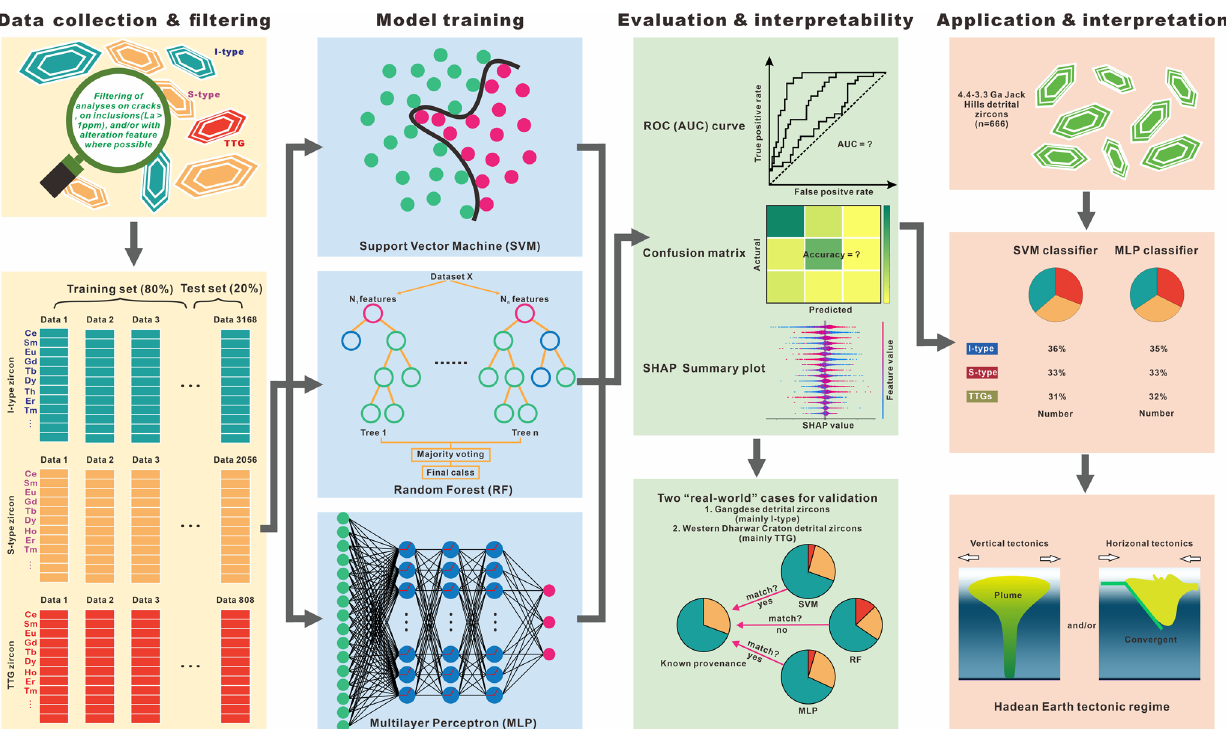
Fig. 2 Overview of the study design. Data collection & fi ltering: compositions of three types of zircons were compiled from publications 52 and fi ltered to exclude analyses on cracks,inclusions,and/or noticeablehydrothermal alteration features.Weused anundersampling techniquetohandletheclass imbalance problem, after which data were split into 80% training and 20% test. 17 features were extracted, including 11 REEs (except La, Pr and Nd), Th, U, Th/U, U/Yb, Ce/Ce*, and Eu/Eu*. Model training: zircon classi fi ers were trained witha tenfold cross-validation hyperparameter search, using the algorithms Support Vector Machine (SVM), Random Forest (RF), and Multilayer Perceptron (MLP). Evaluation & interpretability: classi fi cation performance was measured using metrics commonly used in ML (confusion matrix and ROC curves) and the in fl uence of every input feature value on the model output was explained by the calculated SHAP values 48 ; model performance was also tested using the well-studied detrital zircons from the Gangdese magmatic belt, southern Tibet and the Western Dharwar Craton, southern India. Application & interpretation: SVM and MLP, which show better performance, were used to identify the source rocks of 4.4 – 3.3 Ga Jack Hills detrital zircons; the diverse sources of these detrital zircons indicate a special tectonic environment for Earth ’ s earliest continental